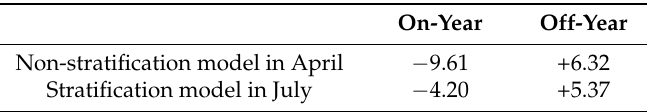
Table 10. Comparison of system errors for on-year and off-year bamboo forest biomass estimation based on non-stratification and stratification